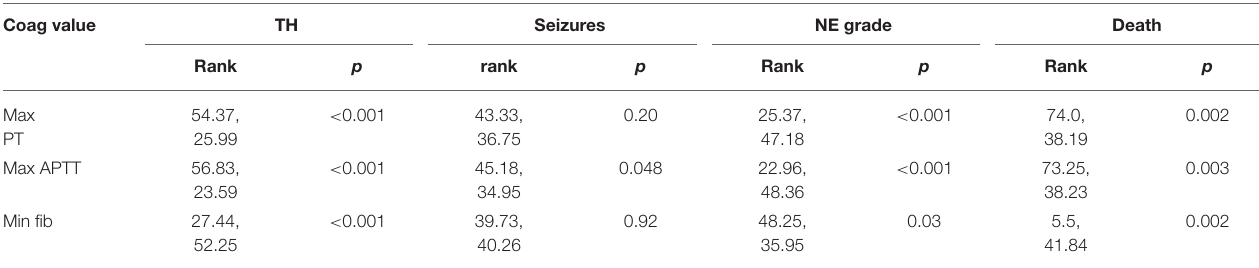
TABLE 4 | Comparison of maximum PT, APTT, and minimum fibrinogen values for each infant with outcomes. Coag